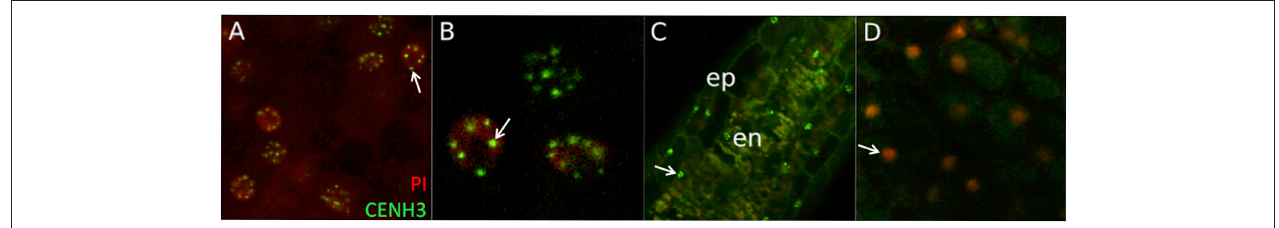
FIGURE 2 | AcGREEN-tailswap-CENH3 localizes to centromeres. These images are representative of those found in all events checked from all four constructs. (A) CENH3 localization has a punctate pattern in the scutellar nuclei of a transgene-hemizygous individual from event * 32A. Arrow indicates a nucleus containing several CENH3+ foci corresponding to centromeres. (B) Close up of (A) . Arrow indicates one CENH3+ centromere. (C) CENH3 localizes to nuclei in the epidermal and endothecial cells of the pre-meiotic ( ∼ 1.0mm long) anther from a transgene-hemizygous individual from event * 32A. Arrow indicates one epidermal cell nucleus with several discrete CENH3+ centromeres. (D) CENH3 was not observed in a transgene-null individual from event *32A. Arrow indicates one scutellar nucleus with no CENH3+ centromeres visible. PI , propidium iodide; ep , epidermal cells; en , endothecial